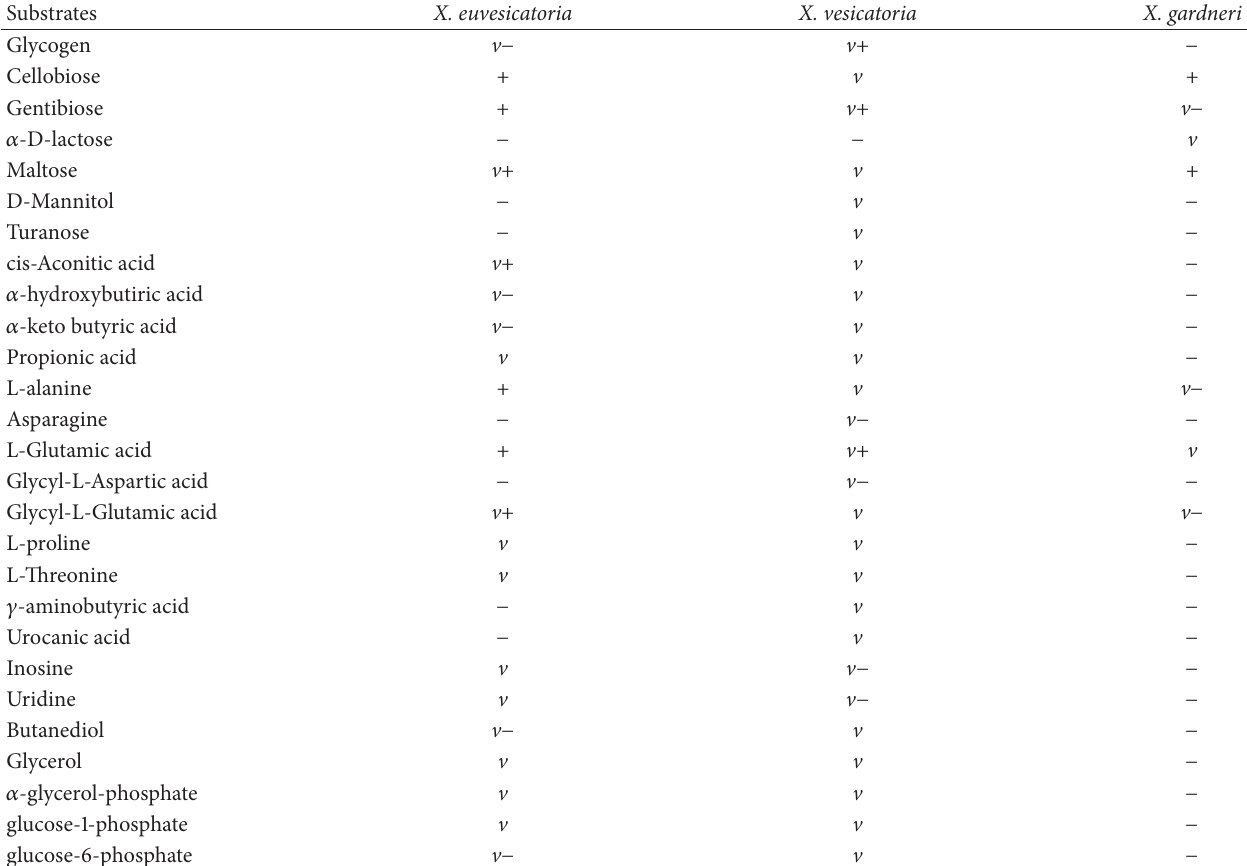
Table 3: Differentiating properties for the three Xanthomonas species according to the metabolic patterns of the Bulgarian strains.